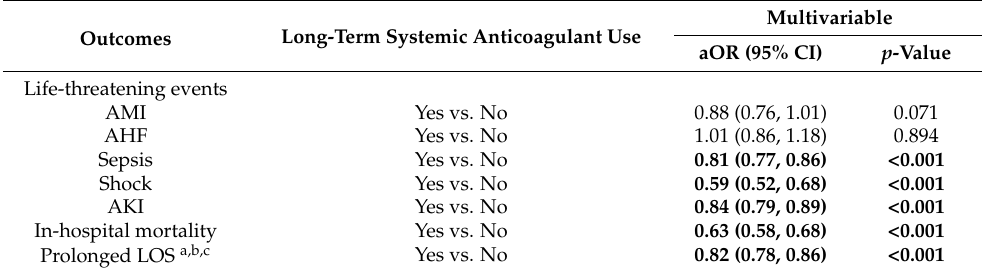
Table 3. Associations between long-term systemic anticoagulant use and inpatient outcomes of patients with pancreatic cancer after